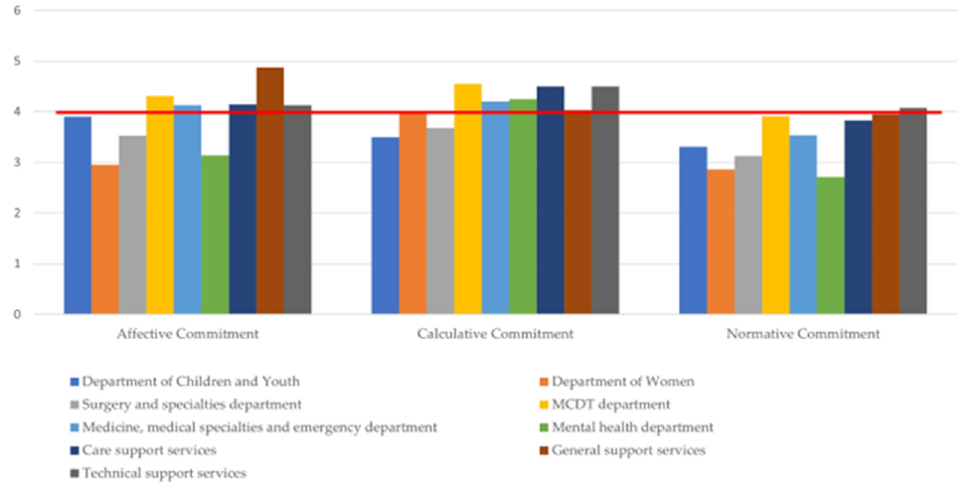
Figure 4. Organisational commitment according to department.